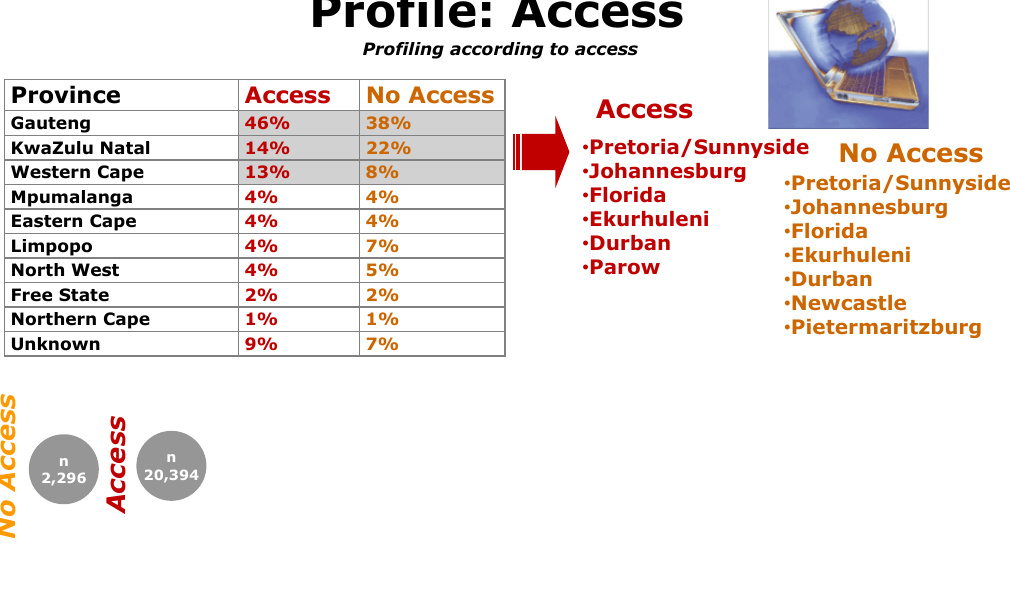
Figure 3. Profile according to access: regional